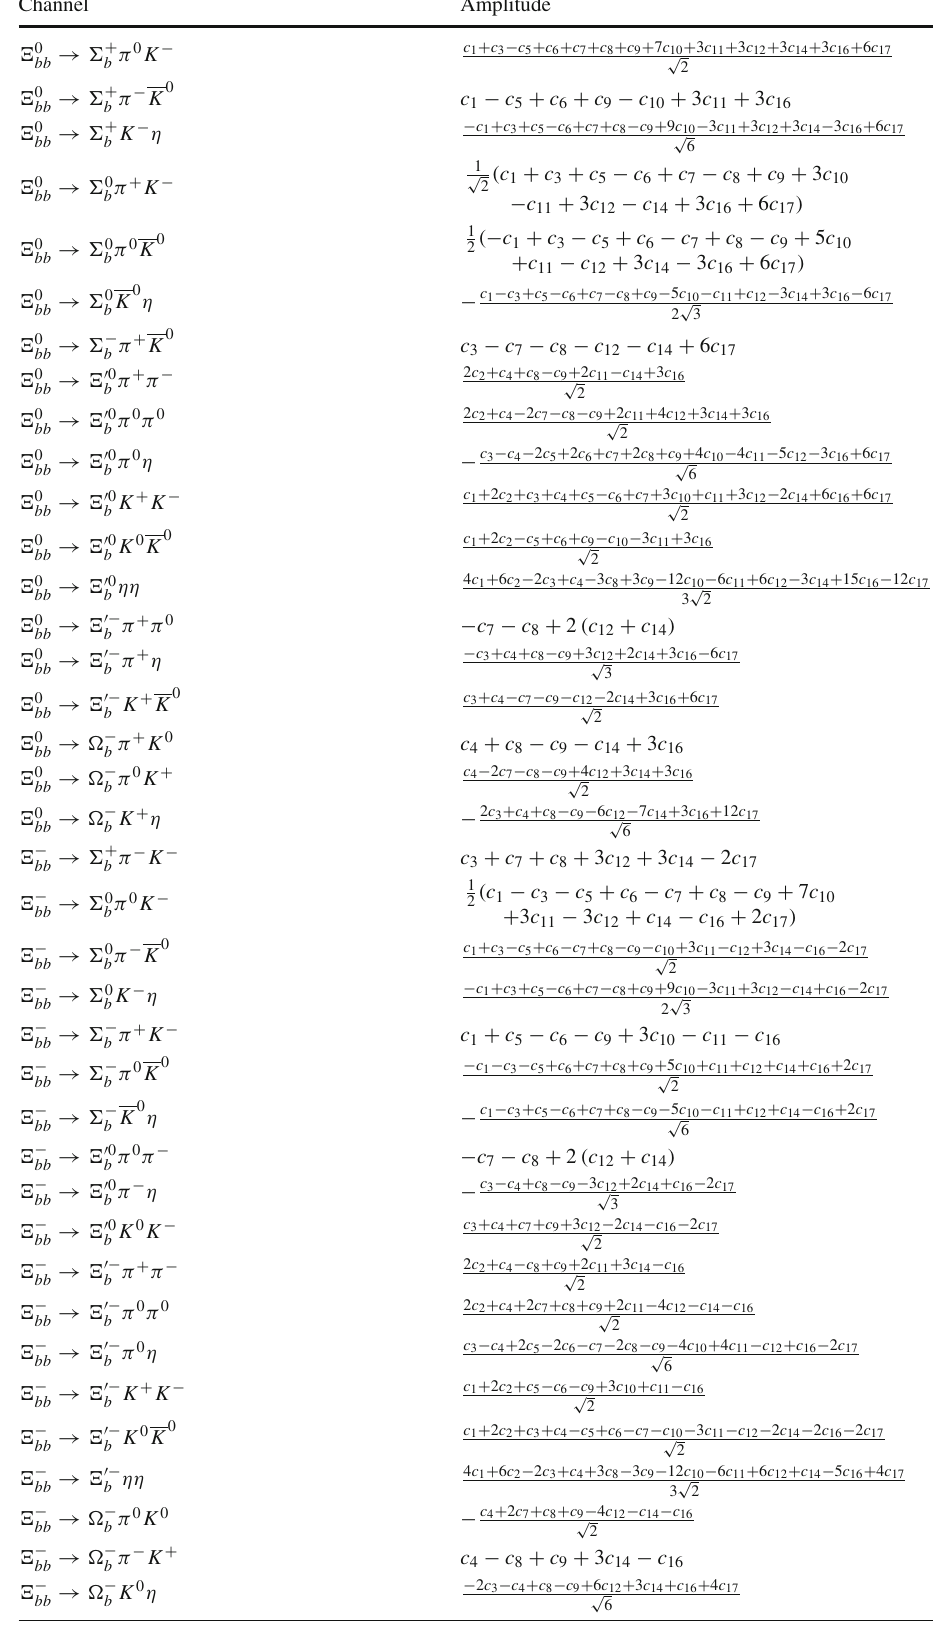
Table 26 Doubly bottom baryon decays into a bqq (sextet) induced by the charmless b → s transition and two light